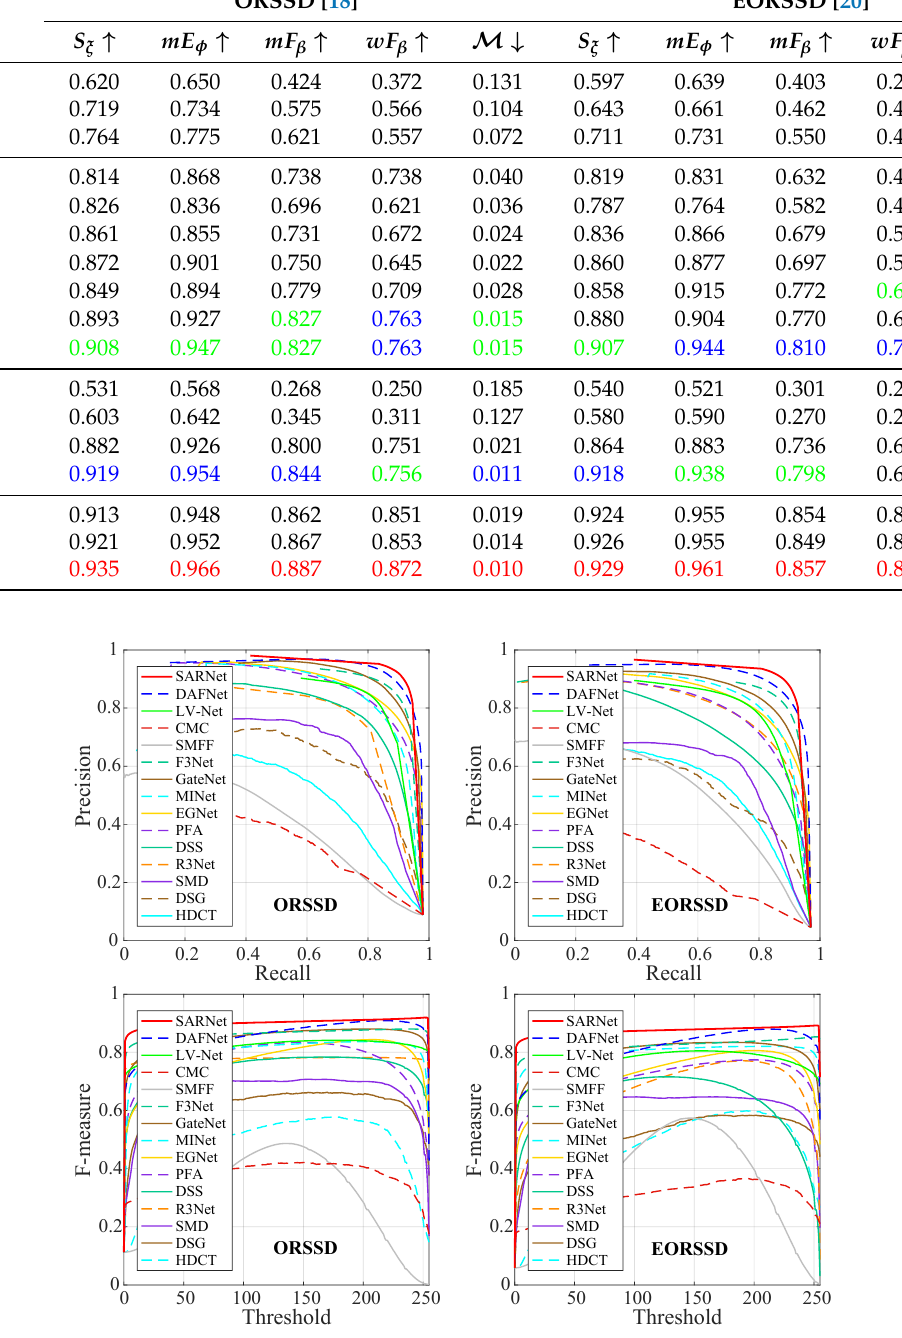
Figure 7. Comparison of PR curves and F-measure curves of 15 SOTA methods over two optical RSI datasets. Best viewed on